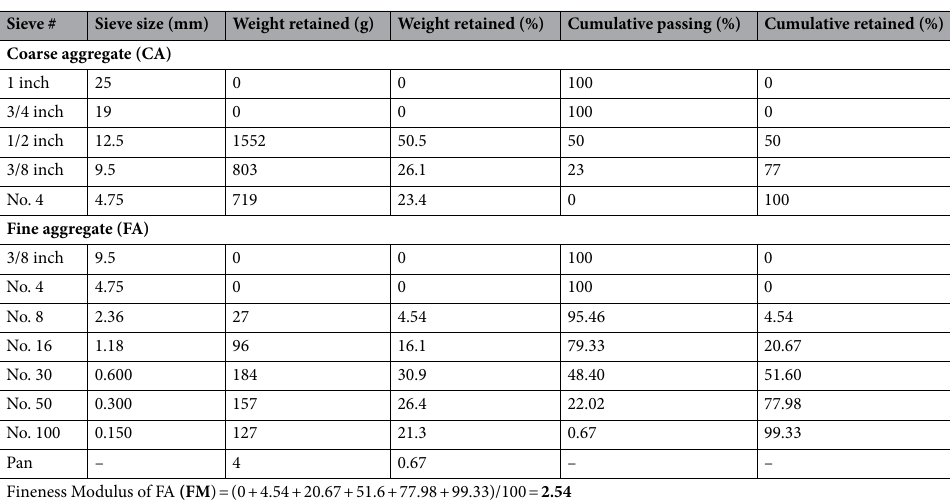
Table 2. Sieve analysis results of coarse and fine aggregates (ASTM